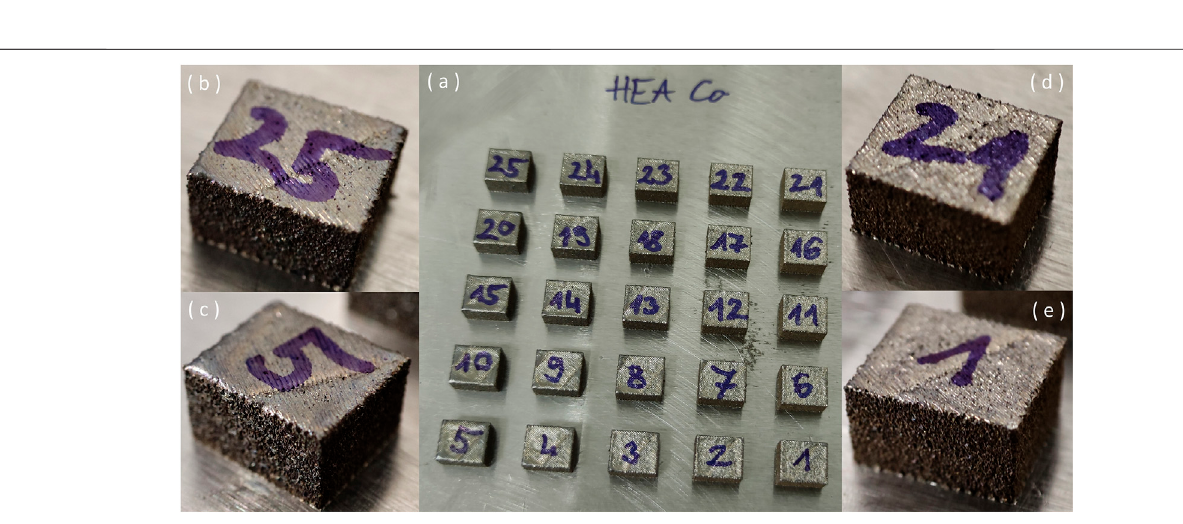
Frontiers in Materials |